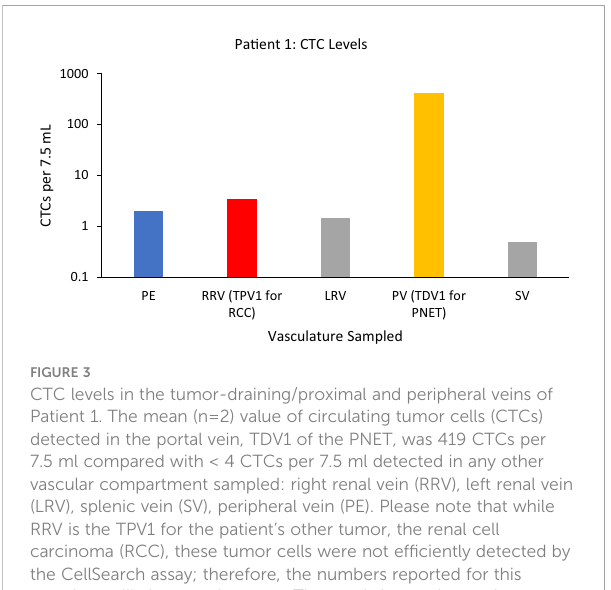
FIGURE 4 Tumor locations and CTC levels for Patient 2. Panel (A) shows enhancing biopsy-proven endometrial cancer mass within the left side of the uterus (red arrow). Panel (B) shows CTC levels from some of the vascular beds sampled, including the left internal iliac vein (LIIV), the TPV2 for this mass. Highest levels were in TPV2, with a possible dilutional effect the further the sampled vascular bed was from the tumor. CTC yield shown is mean (n=2) from 7.5 ml of sampled blood. TPV2 is in red, other sampled veins, the suprarenal inferior vena cava (SIVC, TPV4) the right internal iliac vein (RIIV) and are in grey, and the peripheral sample (PE) is in